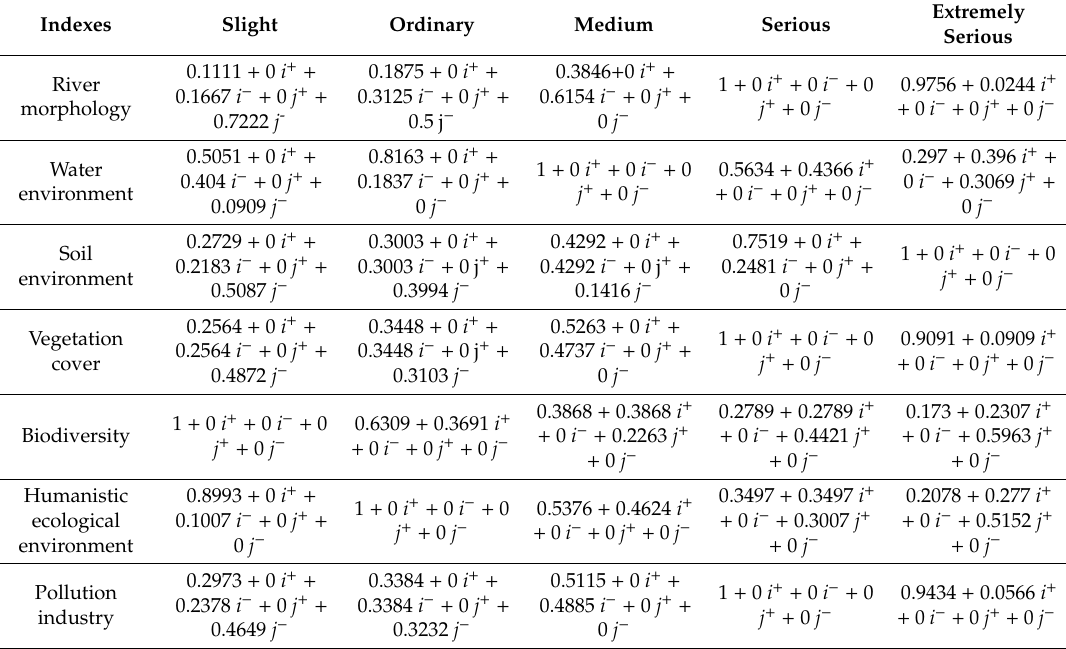
Table 3. Connection degrees corresponding to the five evaluation grades.